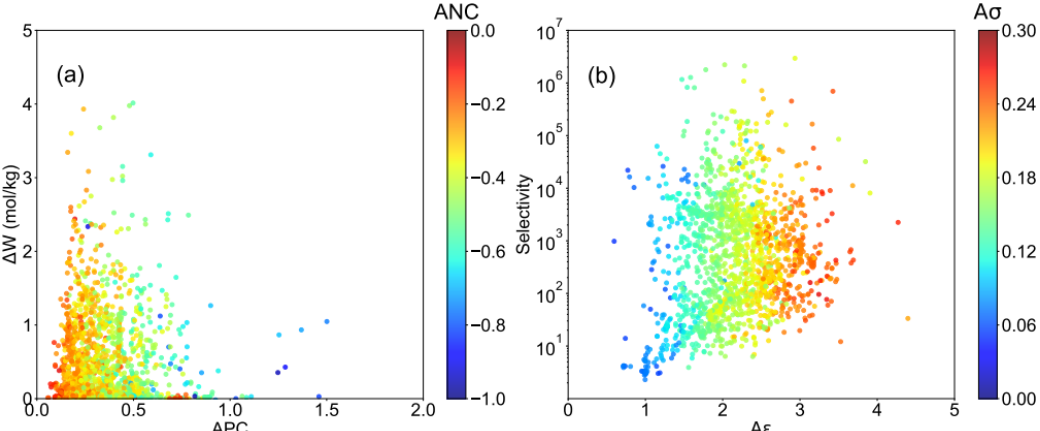
Figure 3. Relationship between descriptors and formaldehyde capture performance, ( a ) correlation between working capacity ( Δ W), and average positive charge (APC) of MOFs, colored by average negative charge (ANC). ( b ) correlation between selectivity (S) and average ε (A ε ) of MOFs, colored by average of σ (A σ ). Table 1. The largest cavity diameter (LCD), maximum explained ratio (MaxER), average positive charge (APC), average ε (A ε ), Henry’s constant (KH), working capacity ( ∆ W) and selectivity (S) of the top 10